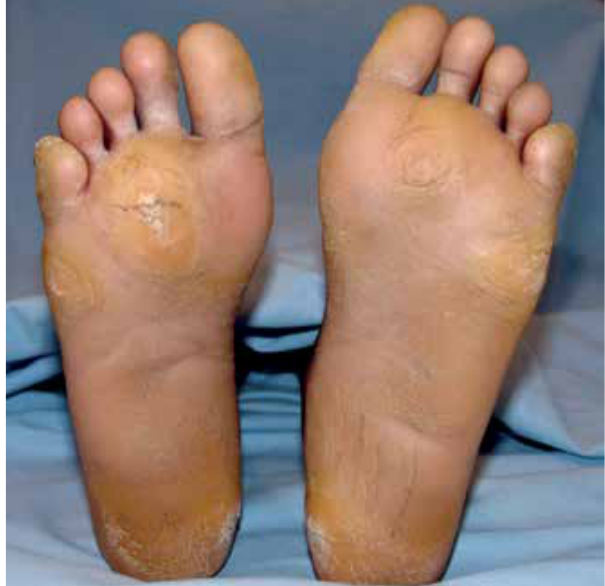
Figure 5: Palmoplantar keratoderma in a patient with pachyonychia